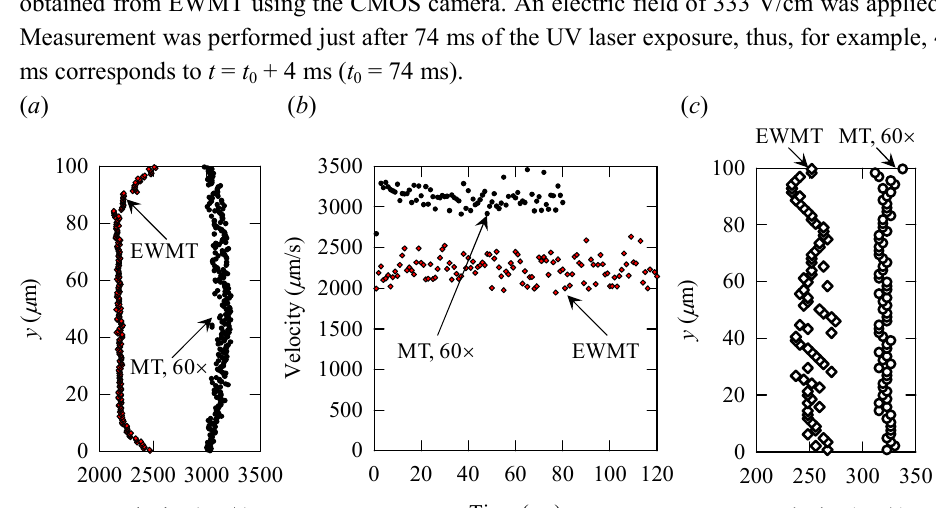
Figure 7. ( a ) Velocity profiles of electroosmotic flow and ( b ) the time evolution of the electroosmotic flow velocity at y = 50 µ m obtained from EWMT and MT by volume illumination with the 60 × objective lens using the CMOS camera. An electric field of 333 V/cm was applied. Measurement was performed just after 74 ms of the UV laser exposure, thus, for example, 4 ms corresponds to t = t + 4 ms ( t = 74 ms). ( c ) Velocity profiles of 0 0 electroosmotic flow obtained from EWMT and MT by volume illumination with the 60 × objective lens using the CCD camera. An electric field of 37 V/cm was velocity of the dye calculated by equation (6) from the measured dye velocity yielded the electroosmotic flow velocity. The velocity profiles using the CMOS and CCD cameras were plotted in Figures 7( a ) and 7( c ), respectively, and the time evolution of the velocity at y = 50 µ m by the CMOS camera is shown in Figure 7( b ). In MT by volume illumination, the midpoint in the depthwise ( Z -) direction was focused with a depth-of-field of 0.76 µ m using the CMOS camera (or 0.66 µ m using the CCD camera). The ensemble averaging was performed using 120 images for EWMT in Figure 7( a ), 80 for MT in Figure 7( a ), 29 for EWMT in Figure 7( c ) and 17 for MT in Figure 7( c ). It is noted from Figures 7( a ) and 7( c ) that the velocities by EWMT are smaller than those by MT. The velocities by EWMT apparently indicate the EOF velocities near the glass wall, while those by MT may show the velocities at around the middle region, as illustrated in Figure 8. This means that that the velocity gradient in the depthwise ( Z ) direction may be formed in the glass-PDMS microchannel.